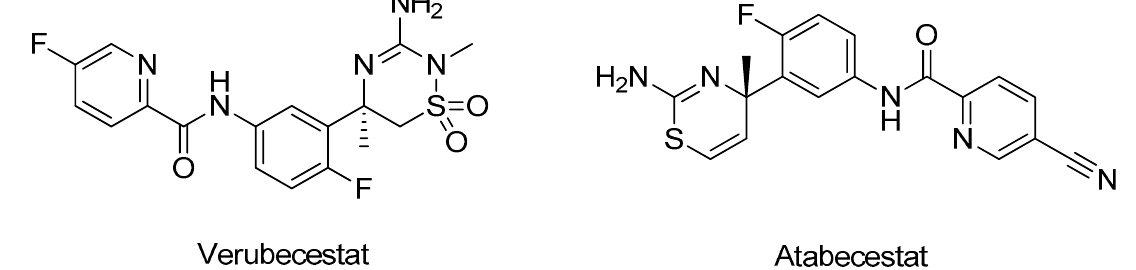
Figure 6. Structure of the BACE-1 inhibitors in clinical trials.